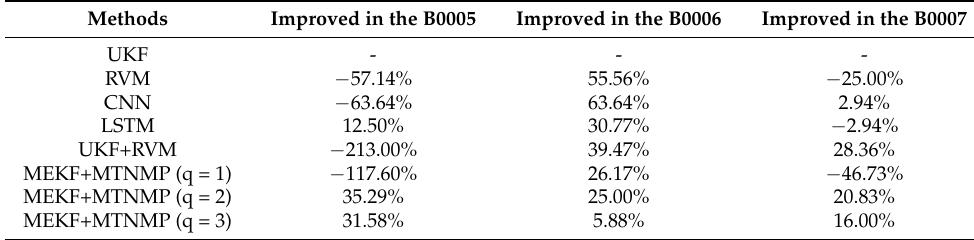
Table 8. The optimization degree of k = 100 relative to k =